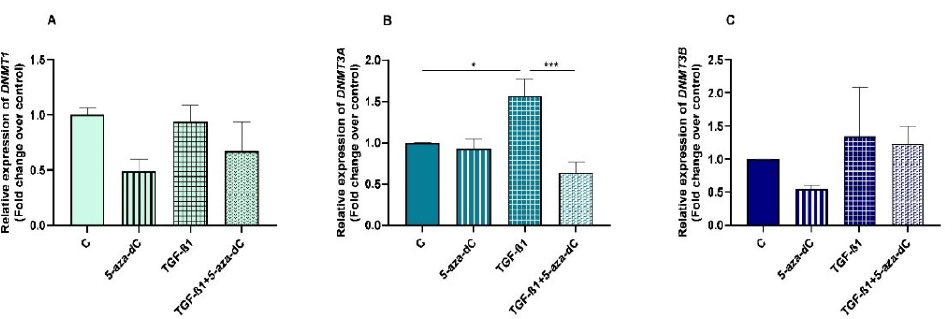
Figure 5. Relative DNA methyltransferases (( A )— DNMT1 , ( B )— DNMT3A and ( C )— DNMT3B ) mRNA levels in non-treated (control-C) mare endometrial fibroblasts or treated with 5-aza-dC (1 µ M), TGF- β 1 (10 ng/mL) for 96 h or both combined (TGF- β 1 followed by 5-aza-dC at 48 h—total cell incubation of 96 h); n = 5. Each treatment was compared to respective control (all groups with control C and TGF- β 1 + 5-aza-dC with TGF- β 1); n = 5. Bars represent mean ± SEM. Asterisks indicate significant differences between treatments (* p < 0.05, *** p <